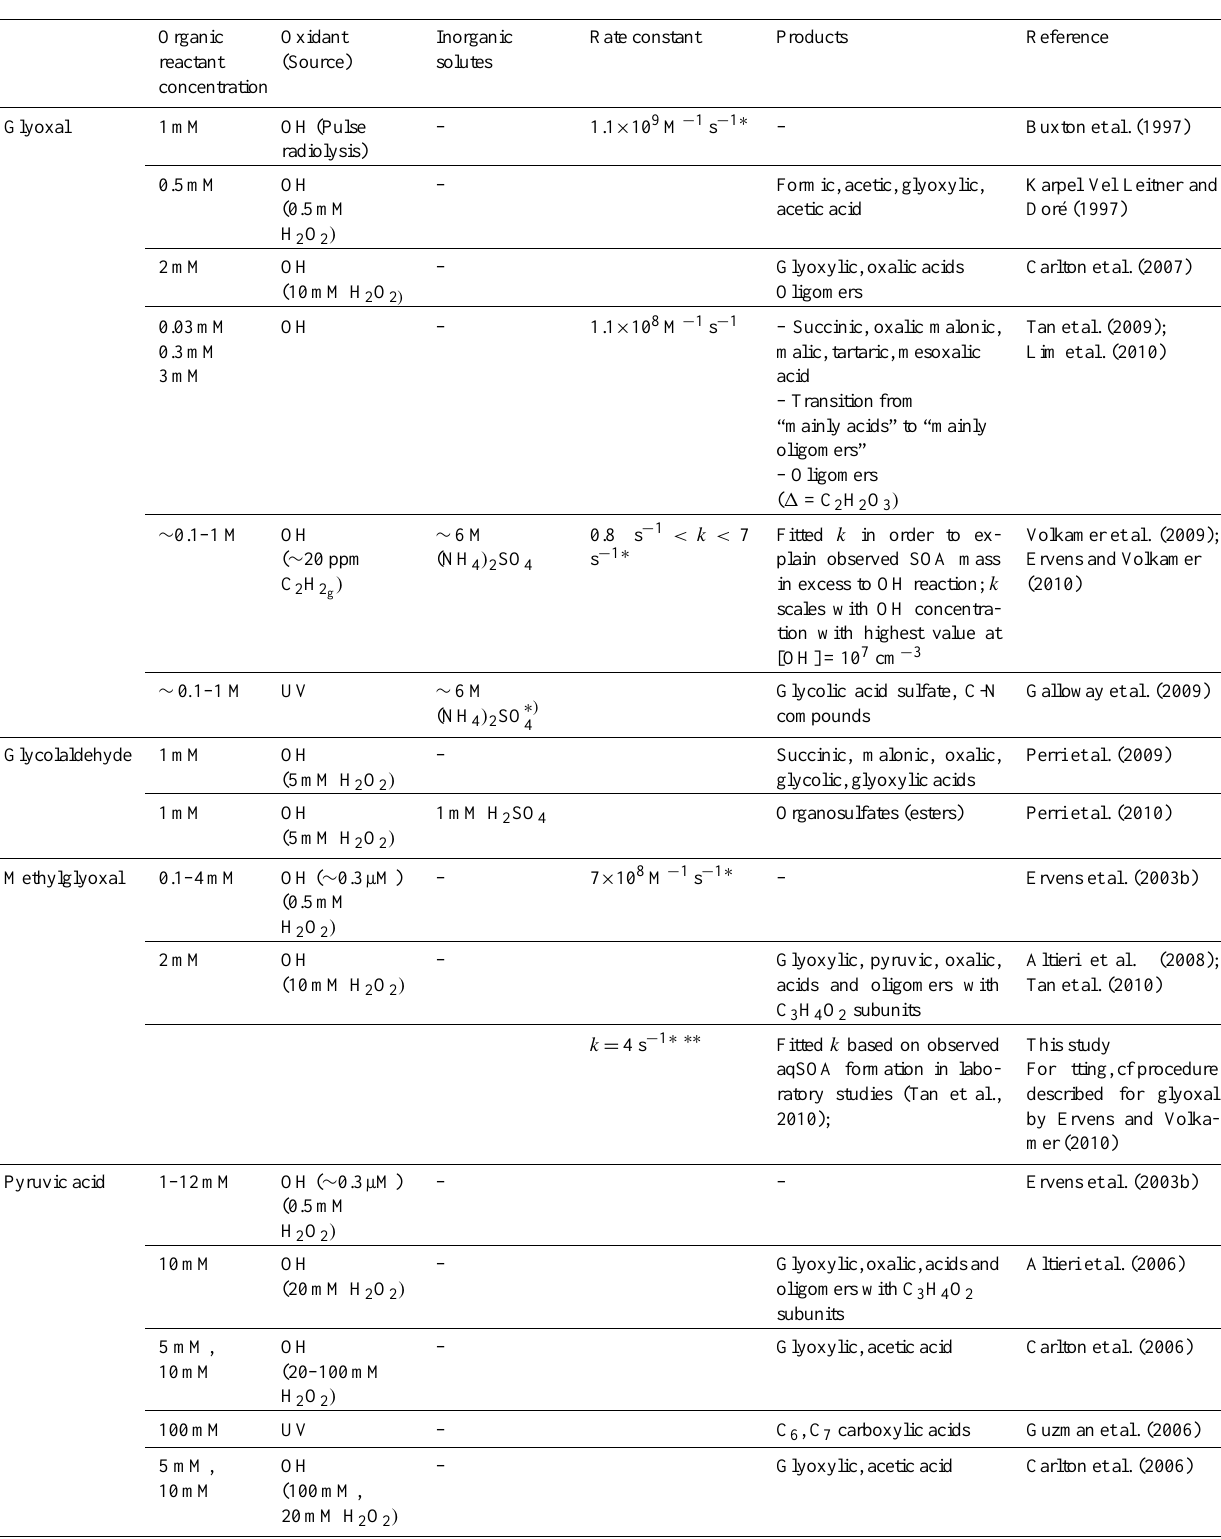
Table 1. Summary of experimental conditions, kinetic data and products from photochemical laboratory experiments leading to aqSOA. Organic